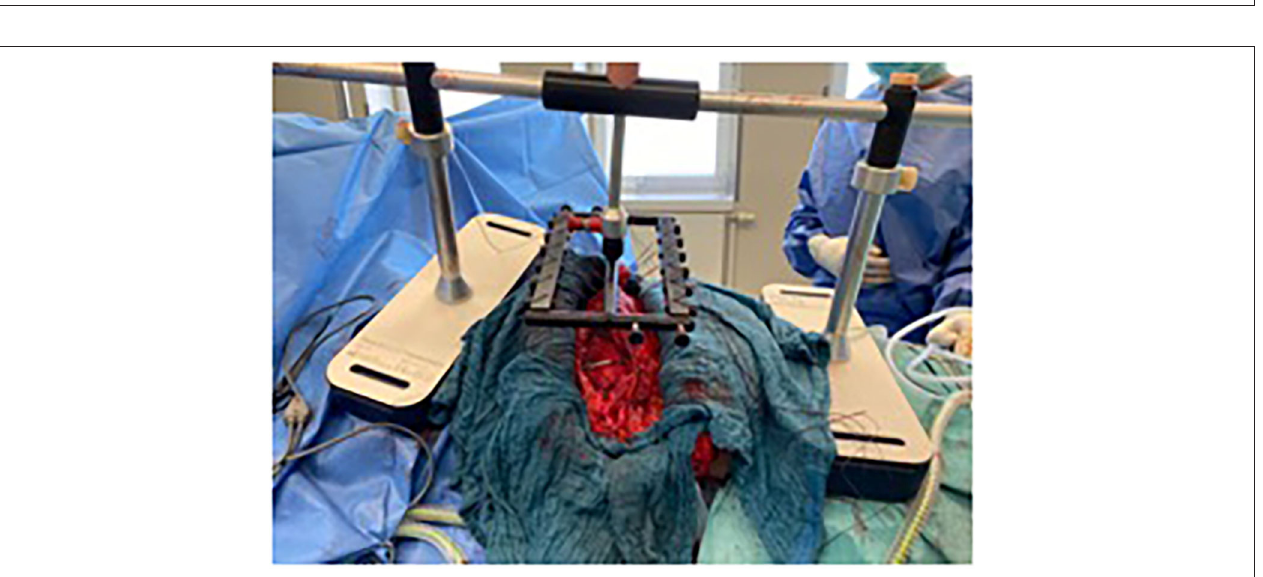
FIGURE 7 | Patient 2 intraoperatively: Fasciotens transverse traction (transversely applied frame), private archive Prof. Dr. H. Niebuhr 9.